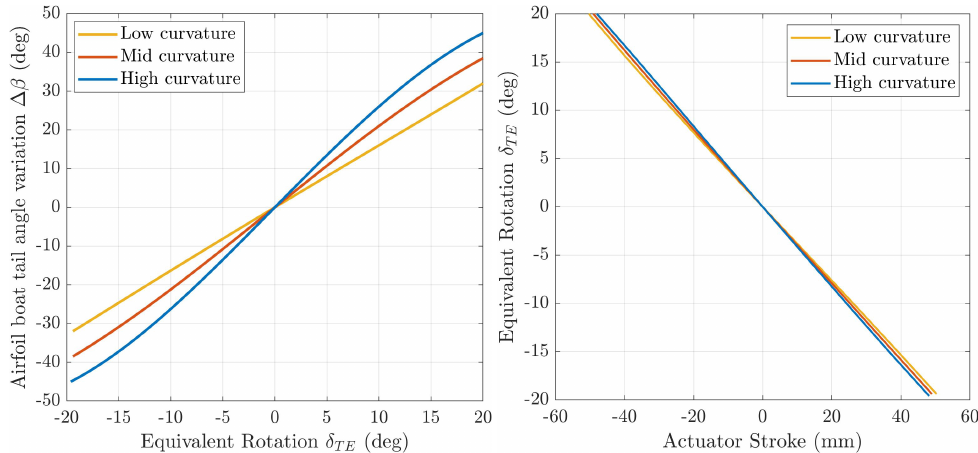
Figure 13. Deflection laws and kinematic relationship between the actuator stroke and the morphing trailing-edge